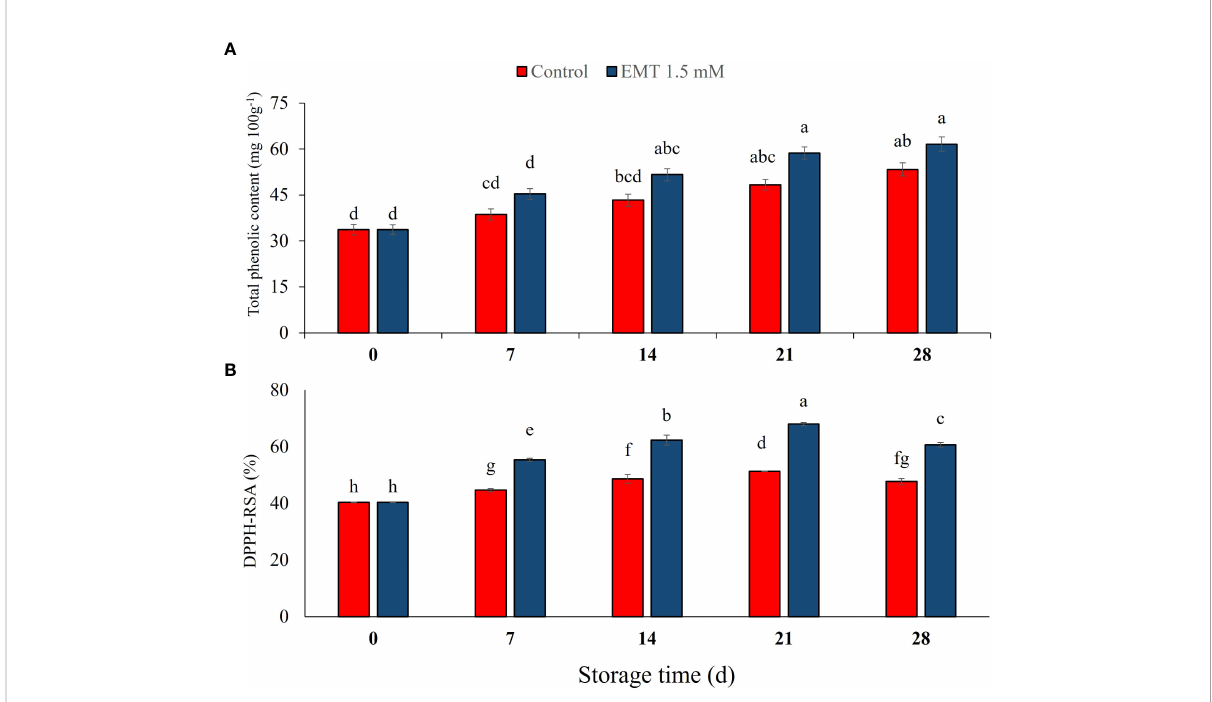
FIGURE 5 Effect of EMT treatment on total phenolic content (A) and DPPH-RSA activity (B) of papaya fruits during cold storage. Data collected from the mean of three replicates, and vertical bars indicate the standard error of the means. Mean values with different letters show signi fi cant differences, and those with the same letters show no statistical difference according to the least signi fi cant difference test ( P <